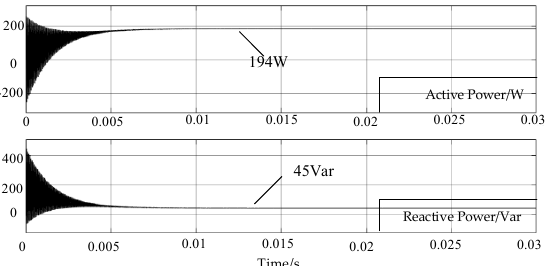
Figure 17. φ AD = 90° and φ AB = 257° active power and reactive power waveforms. Figure 17. ϕ AD = 90 ◦ and ϕ AB = 257 ◦ active power and reactive power